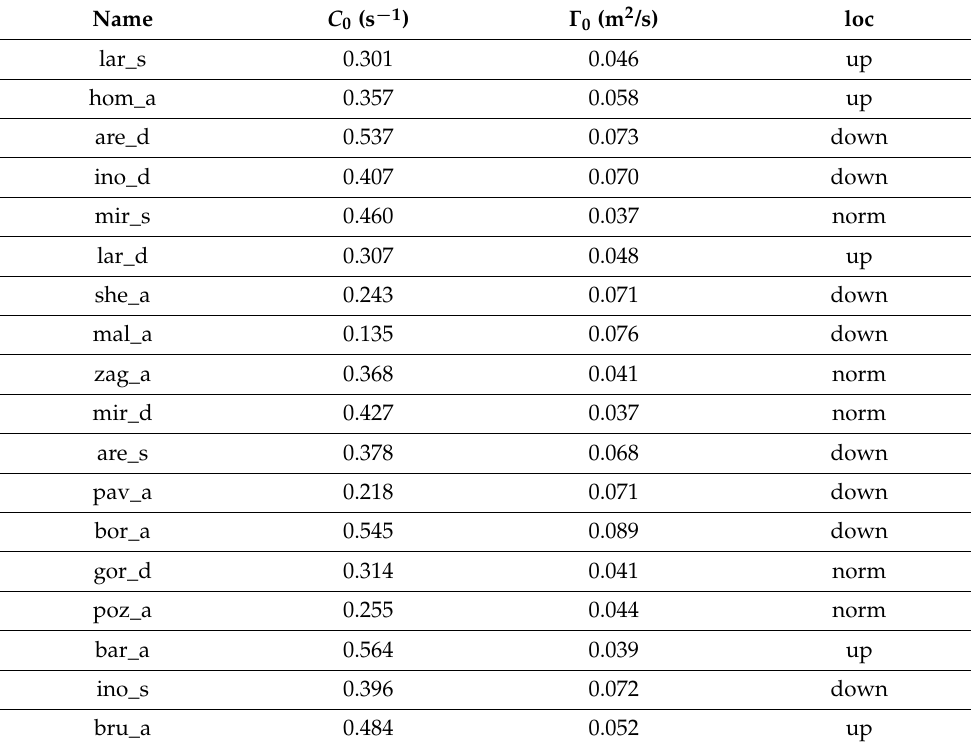
Table 1. Values of constants C 0 and Γ 0 for the studied aortas, ‘loc’—localization of aortic